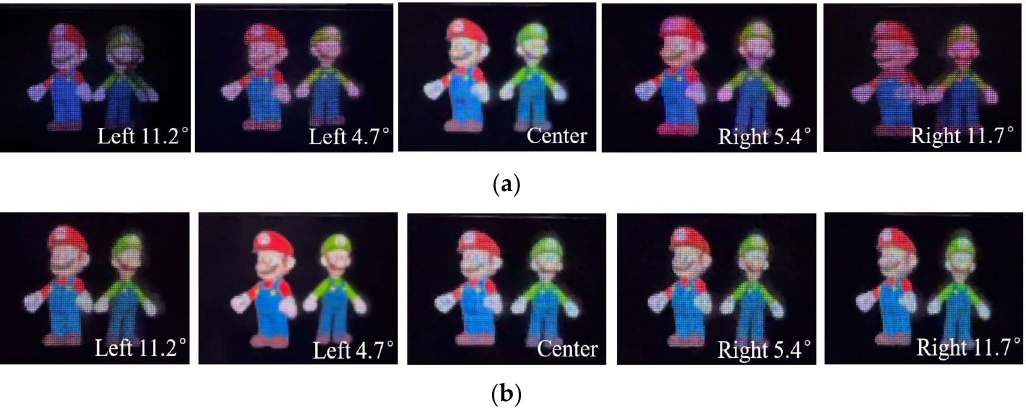
Figure 9. Captured 3D images for ( a ) the conventional EIA and ( b ) the FEP-EIA with L = 450